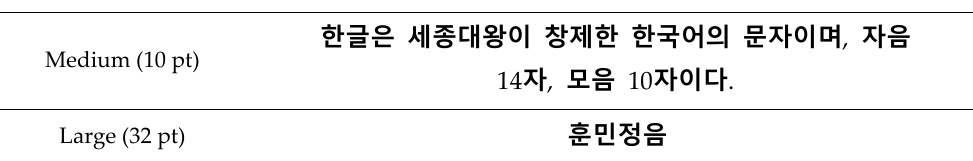
Table 7. Ground-truth as a result of a small font survey.